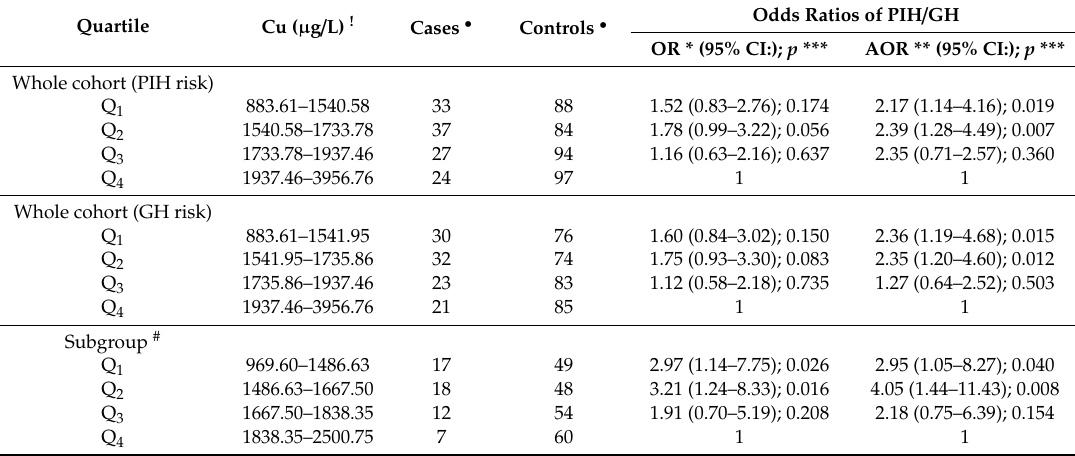
Table 3. The odds ratios of PIH / GH for Cu